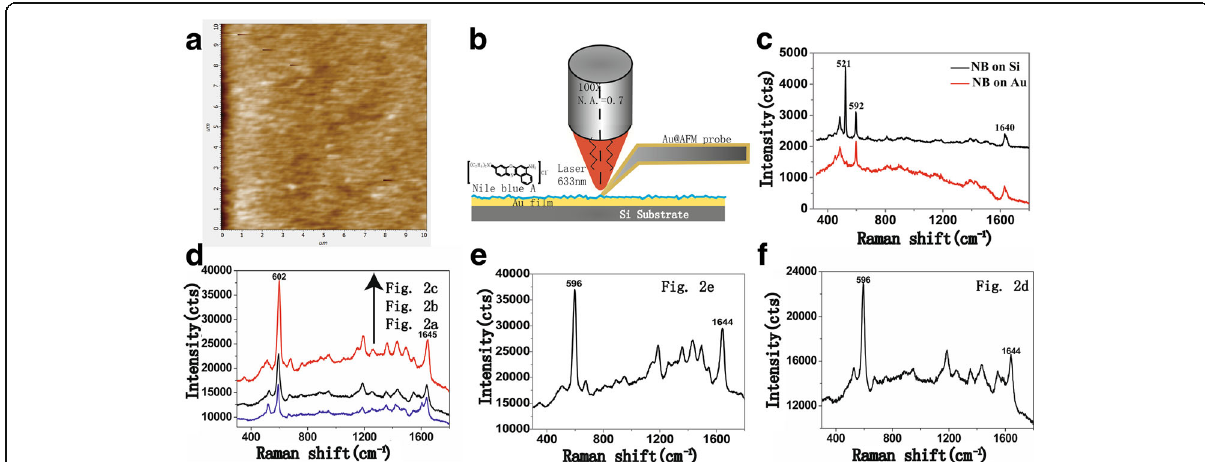
Fig. 3 a The AFM image of Au substrate. b Schematic diagram of a TERS experiment. c Raman spectrum of Nile blue (NB) monolayer with tip retracted. d Raman spectrum detected by the probes in Fig. 2,a – c. e Raman spectrum detected by the probe in Fig. 2e. f Raman spectrum detected by the probe in Fig.